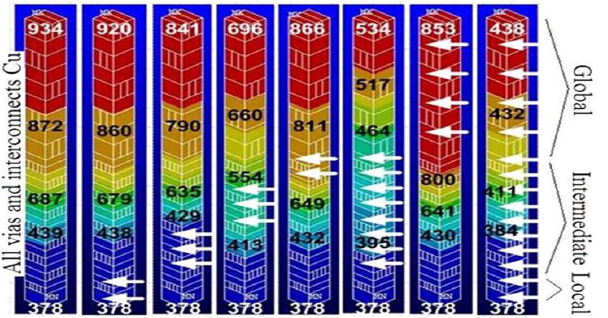
Figure 7. Interconnect temperature map of vias at different levels obtained from 3D finite-element electrothermal simulation at 22 nm node. The parts pointed by the white arrows are composed of CNT bundles, and the other parts are composed of Cu. Reprinted with permission from ref. [24]. Copyright 2009, IEEE.